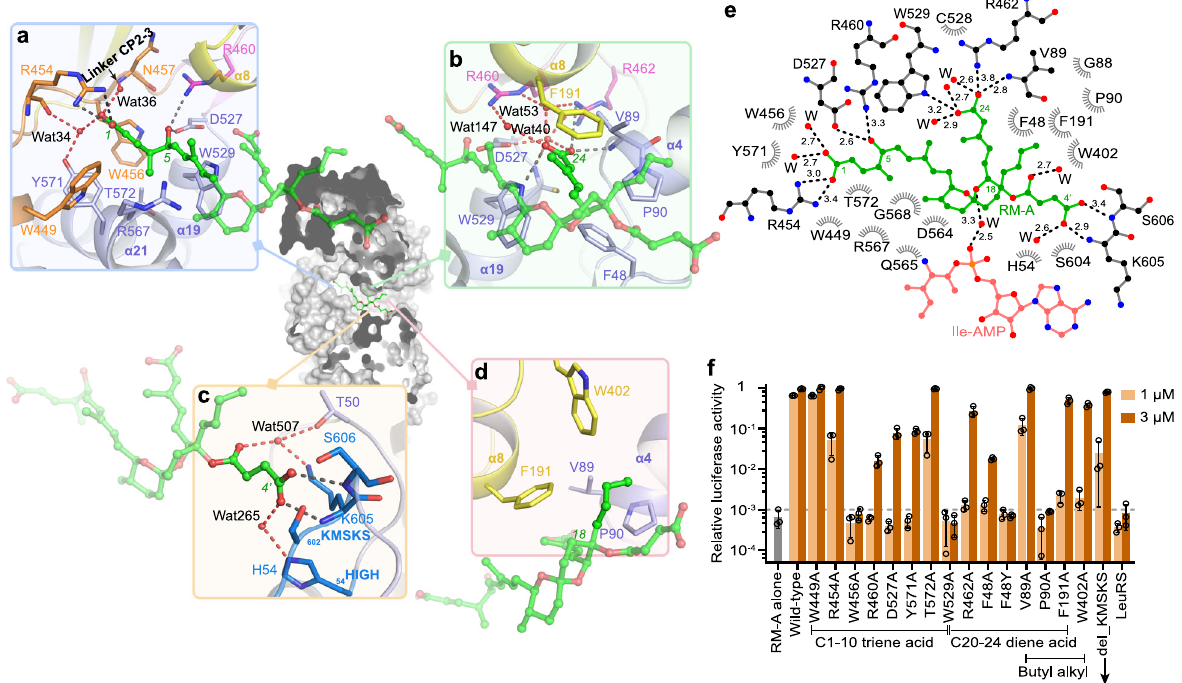
Fig. 2 RM-A interacts with Sc IleRS from multiple directions and forms extensive polar interactions and hydrophobic contacts with Sc IleRS. a Zoomed- in view of the binding site of the C1-10 triene acid segment of RM-A. The hydrogen bonds formed with water molecules (red spheres) are indicated as red dashed lines, and the polar interactions between RM-A and the residues of Sc IleRS are described as black dashed lines. b – d Zoomed-in view of the binding sites of the C20-24 diene acid moiety ( b ), the hemisuccinate ( c ), and the butyl alkyl side chain ( d ) of RM-A. e Two-dimensional presentation of RM-A binding. The ligands RM-A and Ile-AMP and the residues forming polar interactions with RM-A are shown in ball-and-stick representations, and other residues within 4.5 Å of RM-A are shown in grey. The H-bonding structural water molecules (W) are shown in red spherical models. f C-terminal truncated Sc IleRS or its variants at 1 μ M or 3 μ M were added to rabbit reticulocyte lysate to test their capability to rescue the protein translation inhibited by 200 nM RM-A. Almost all of the mutations, except W449A, strongly reduced the rescue capability of Sc IleRS. All error bars represent standard deviations (SD) of three independent ( n = 3) experiments, and the data are presented as mean values± SD. Source data are provided as a Source Data fi